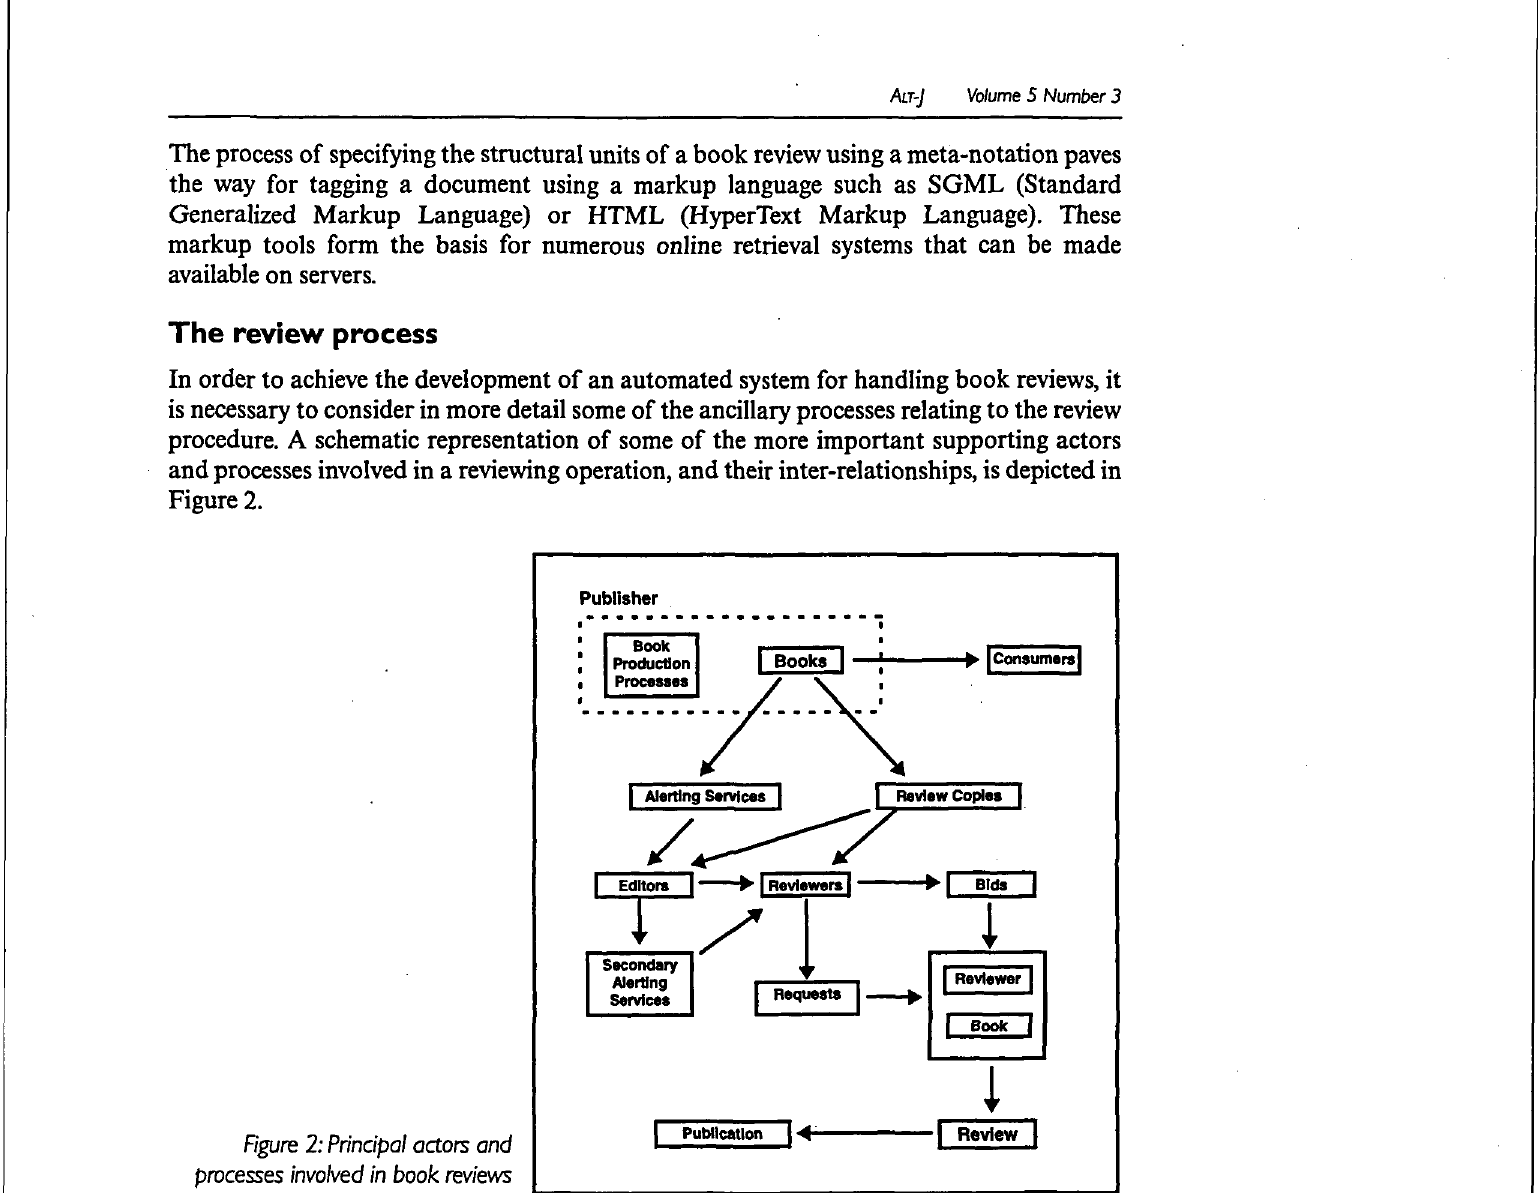
figure 2: Principal actors